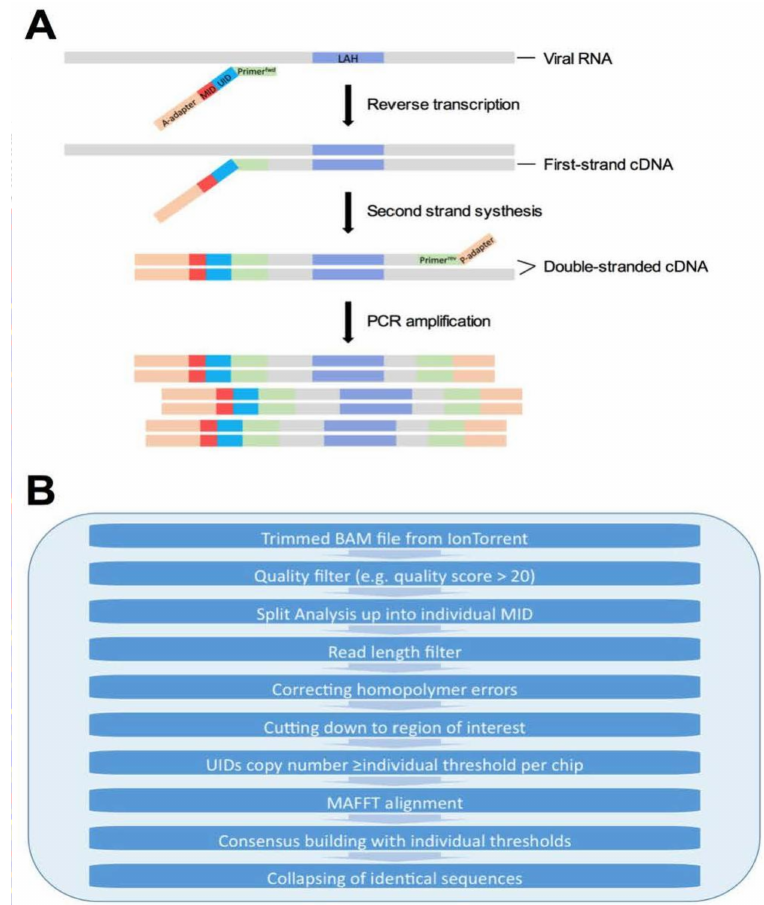
Figure 3. Overview of ( A ) library preparation using unique identifiers (UID) and ( B ) processing pipeline used for deep sequencing data cleanup.